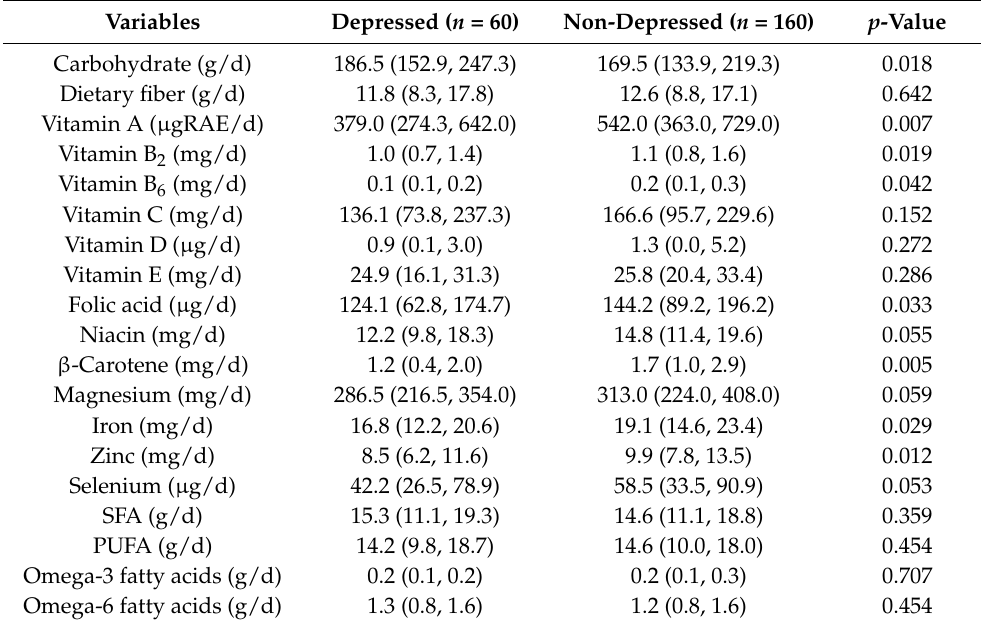
Table 2. Dietary nutrient intakes of the depressed and non-depressed breast cancer